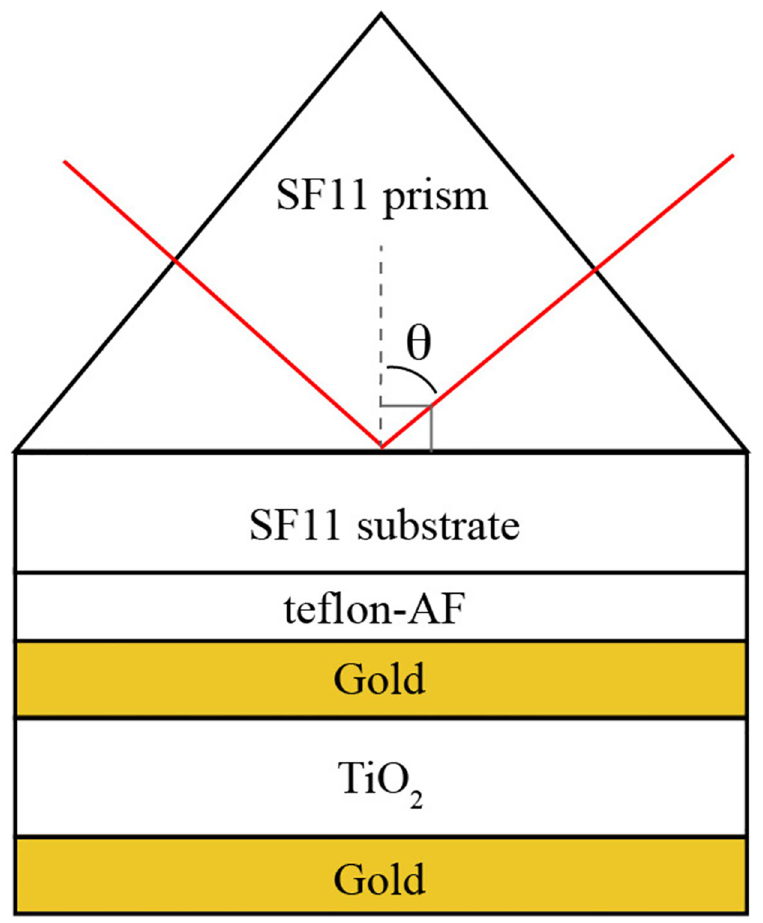
Fig 3. Schematic structure of the device reported in this study showing the defined internal